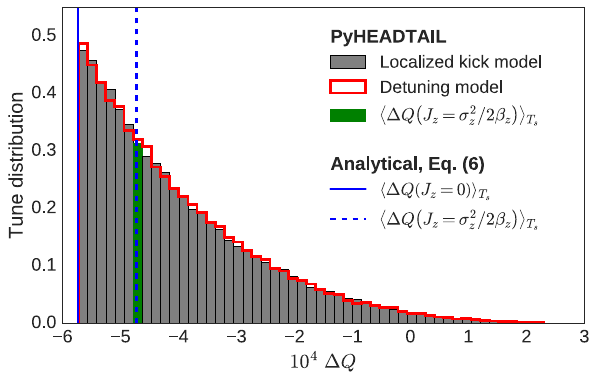
FIG. 7. Comparison of the incoherent betatron tune distribu- tions introduced by an rf quadrupole for the detuning (red) and the localized kick (grey) model implemented in P y HEADTAIL . Both models give consistent results. The detuning obtained from P y HEADTAIL for particles with respectively J z ¼ σ and J z ¼ 0 is in good agreement with analytical calculations (blue).